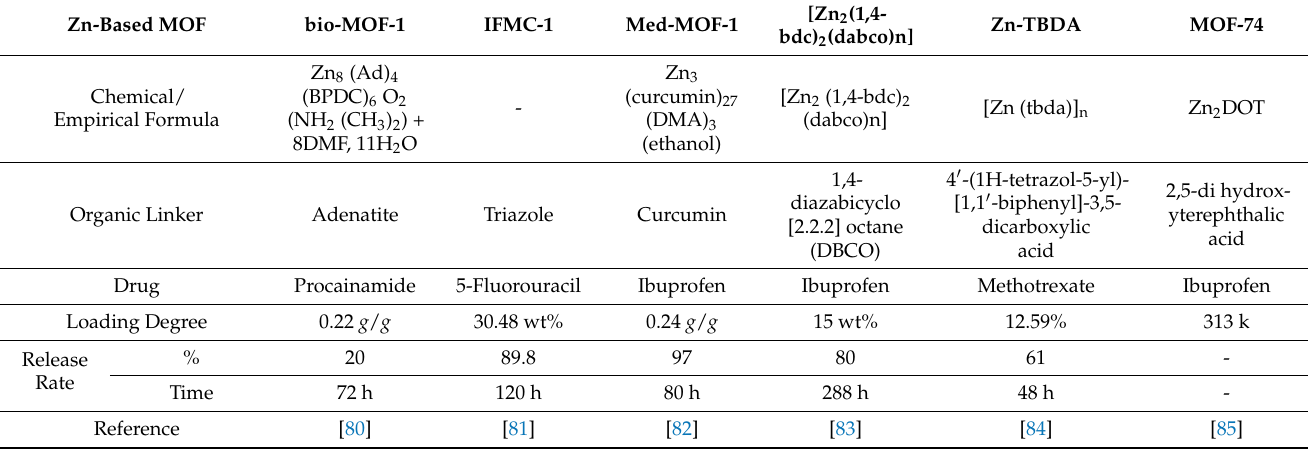
Table 1. Details about recently developed Zn MOFs: their structure, drug loading and release